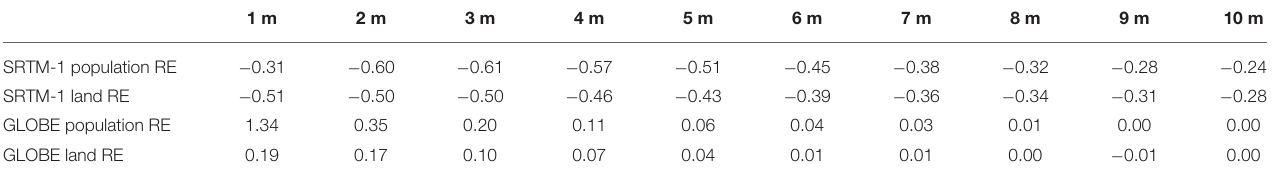
TABLE 3 | Population and Land exposure relative error for the contiguous USA (omitting VA and RI) under SRTM-1 and GLOBE. 1 m 2 m 3